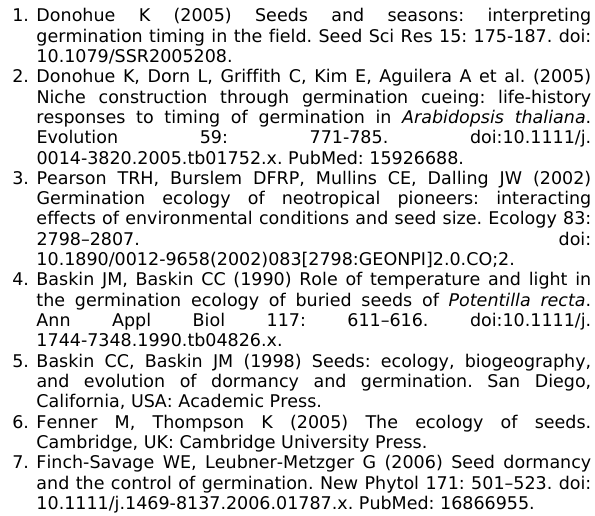
Daily temperature fluctuation on the eastern Tibet Plateau (Maqu) and three other places with the similar latitude but different